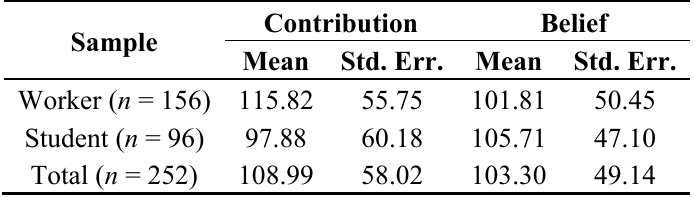
Table A10. Unconditional contributions and beliefs.